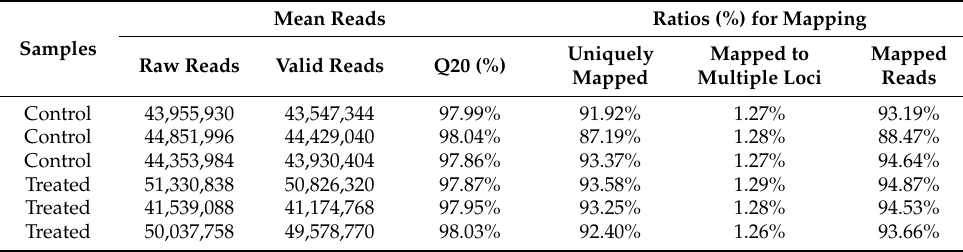
Table 1. Statistical summary analysis of RNA-seq data sets of treated and control